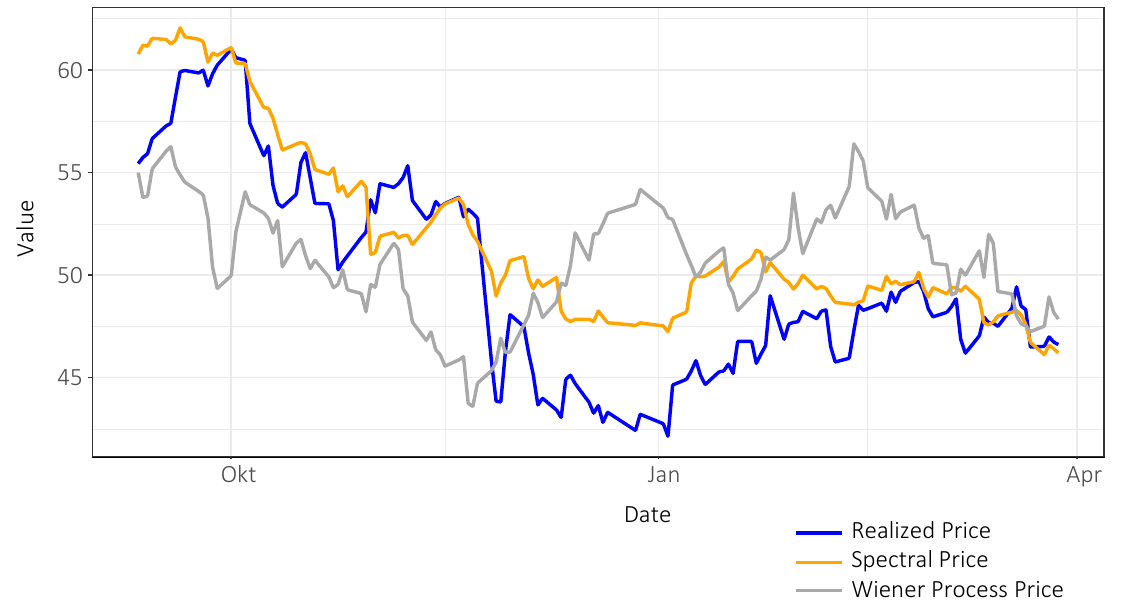
Figure 3. Comparison of simulation results vs the realized stock